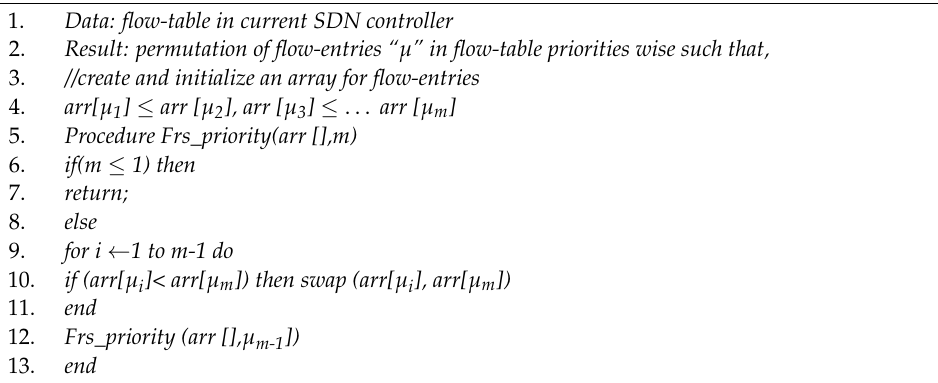
Algorithm 2: Priority-Wise Sorting of Heterogeneous SDN Domains in the